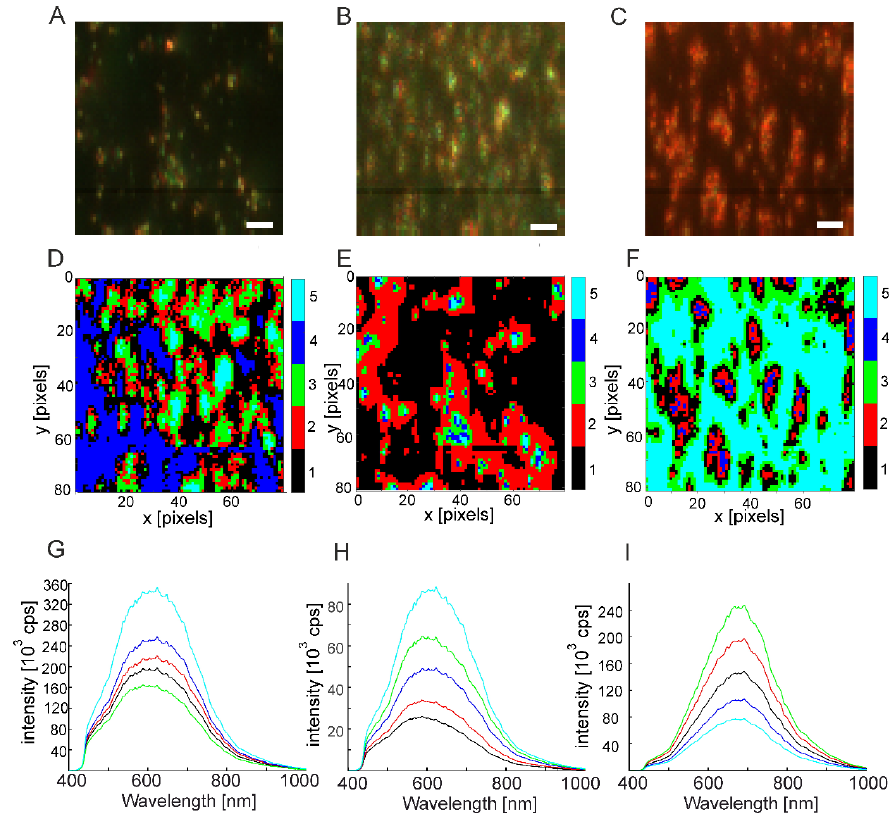
Figure 4. RGB images obtained from data sets of ( A ) gold nanoparticles, ( B ) gold nanoaggregates prepared with sodium chloride and ( C ) gold-BSA agglomerates. Each mapping data set comprises 6399 spectra. ( D – F ) Respective hyperspectral maps from the result of hierarchical cluster analyses (HCA) applied to the data sets without pre-processing. Mapping was based on five spectral classes; each assigned a different color. ( G – I ) Average spectra calculated from the different classes in each data set; colors correspond to pixel colors in D, E, and F, respectively. Scale bars: 2 µm. The averaged spectra from each of the classes (Figure 4G–I) show maxima at different positions in the three samples and also between the different classes within each map. In the aggregates formed by adding sodium chloride (Figure 4E,H), a shift is observed from the regions of lower scattering intensity (black), mainly caused by individual nanoparti- cles and/or small aggregates, and those from the center of the microstructures (blue traces), that have contributions from more red-shifted resonances. In agreement with the RGB image, all averaged spectra in the sample prepared with BSA show a red shifted maximum compared to those in Figure 4G,H and also lack a pronounced shoulder at low wavelength. Since most information on the individual spectra is lost during averaging of the spec- tra after the cluster analysis, an analysis of the individual pixel spectra was performed using NMF. Moreover, here, a decomposition into four components proved optimal to resolve different resonances while enabling comparison of similar bands between the dif- ferent samples. Figure 5 shows the results of the decomposition by NMF as maps that are based on the relative contribution of each of the four components to each pixel (Figure 5A,C,E), resulting in four images for each of the three samples (Figure 5B,D,F, matching colors).